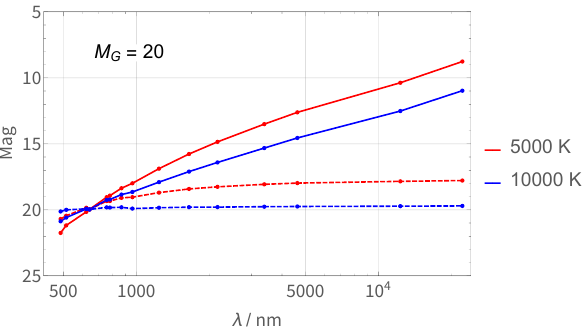
Figure 5. Solid: predicted bremsstrahlung-like pseudo-spectrum of a mirror star with an optically thin SM nugget at a temperature of 5000K (red) and 10000K (blue) in the simplified signal calculation of [9]. Dashed: blackbody at same temperature for comparison. Each dot ( λ a survey passband X, see eqs. (3.1) and (3.2). All curves are normalized to an apparent magnitude of 20 in Gaia’s G